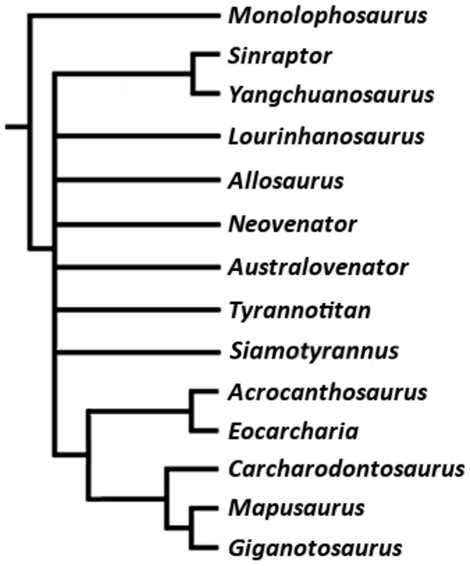
Phylogeny of Allosauroidea upon the inclusion of proposed taxa known
from highly fragmentary specimens.Included taxa are Siamotyrannus,
Lourinhanosaurus, and
Australovenator. A full phylogenetic analysis of 20
terminals recovered 11 MPT's (TL  =  338
steps), the strict consensus of which is shown. This phylogeny has been
cropped to show only allosauroid relationships, as the outgroup taxa
were unaffected.